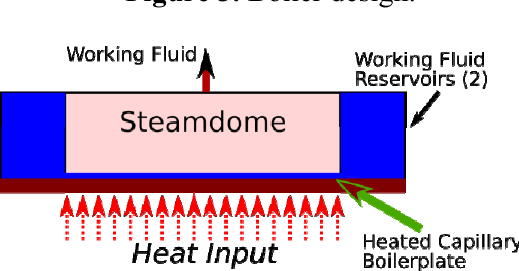
Figure 3. Boiler design.